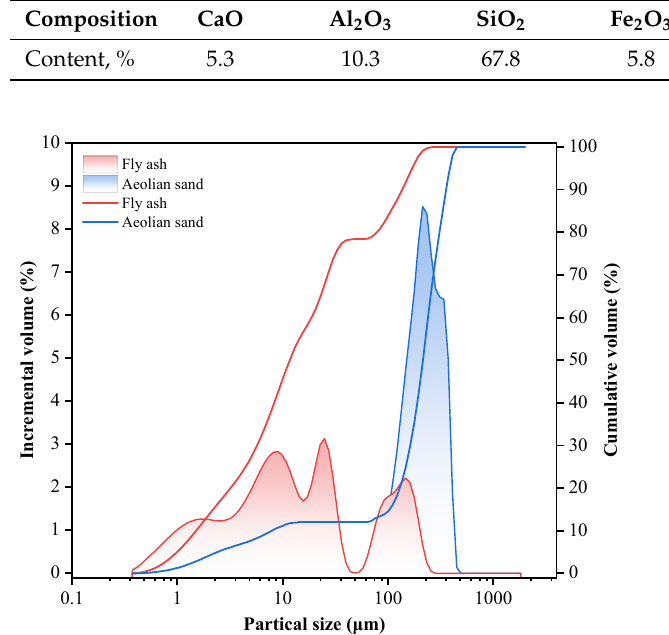
Table 1. Main chemical composition of Aeolian sand.